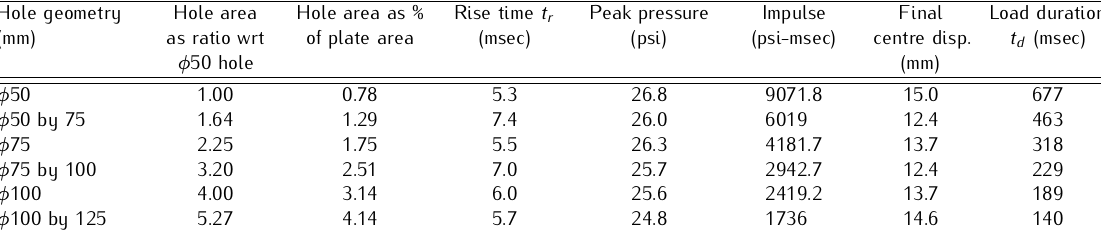
Table 2. Test data for square plates with circular holes loaded to nominally 25